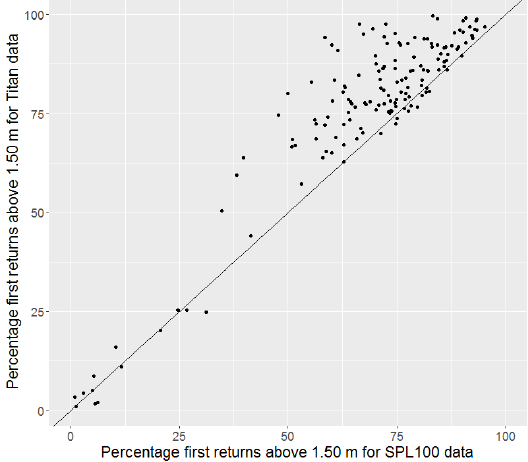
Figure 5. The plot shows the difference in the percentage of first returns above 1.5 m between the two systems SPL100 and